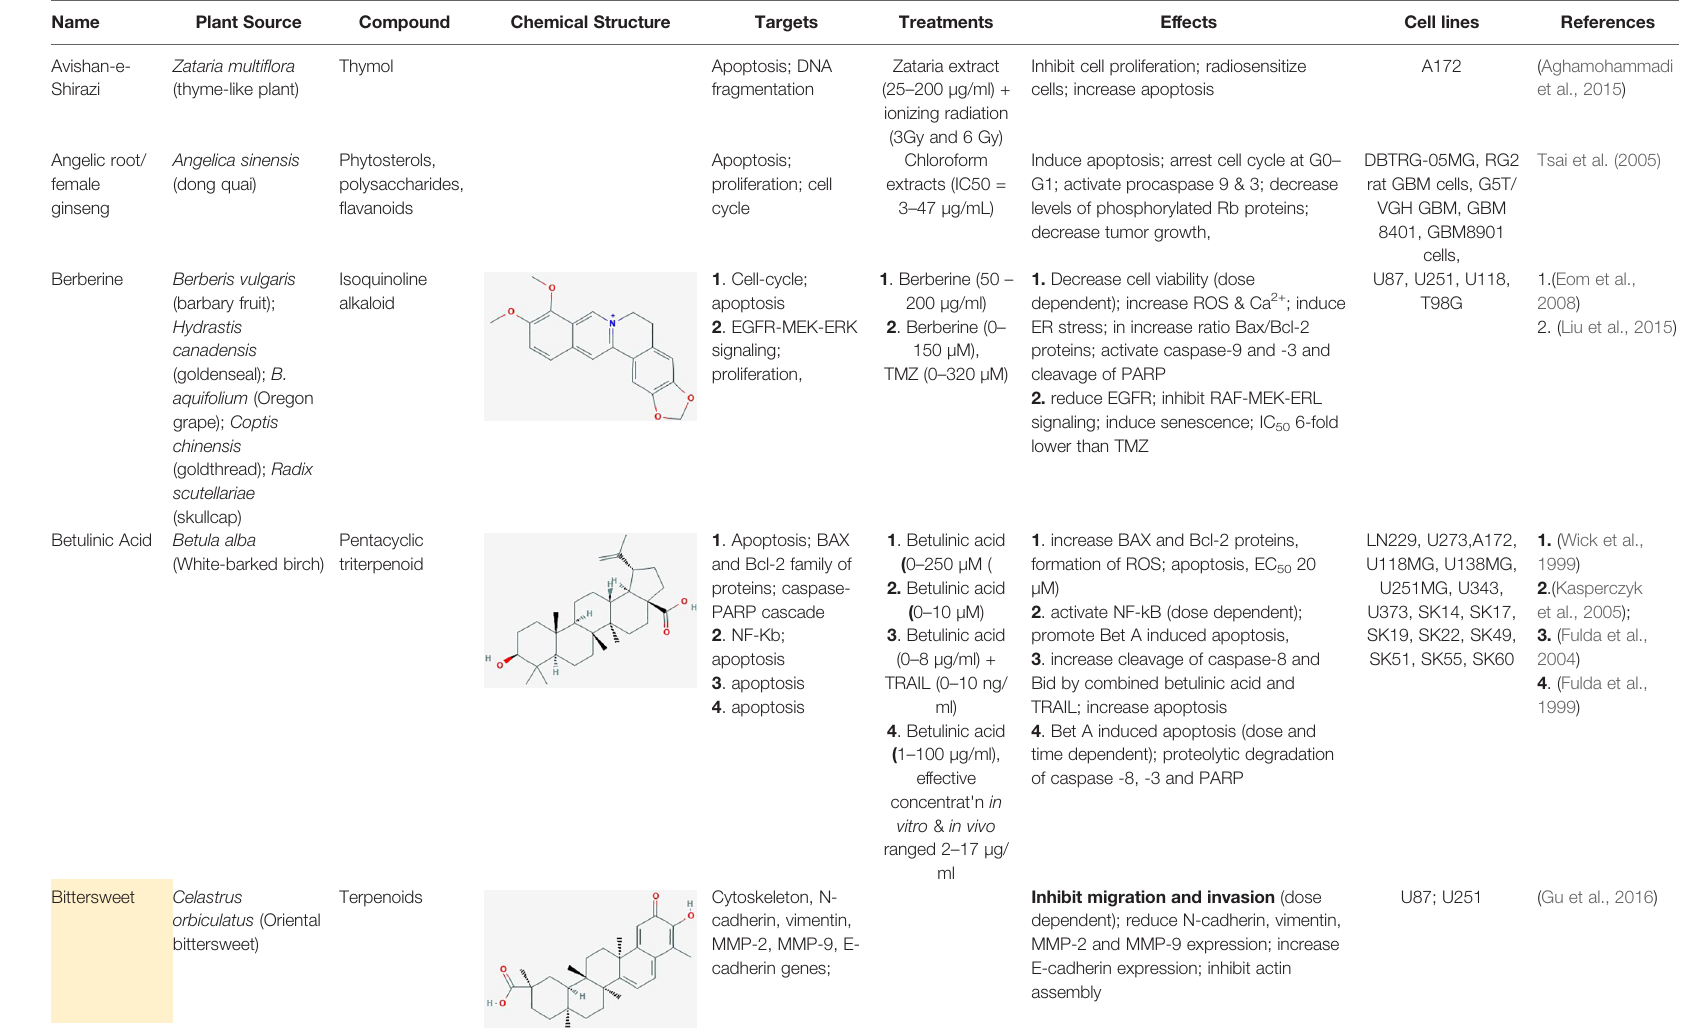
TABLE 2 | Summary of alternative medicinal compounds and extracts reported to affect proliferation, viability, and/or motility of glioblastoma and malignant brain tumor